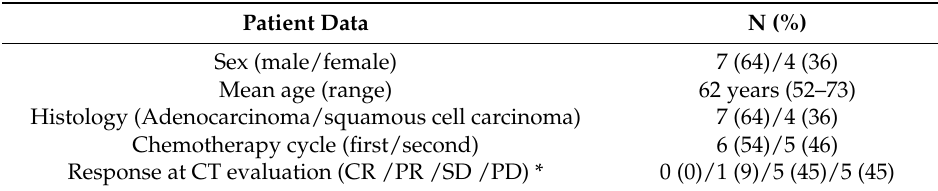
Table 1. Patient characteristics.